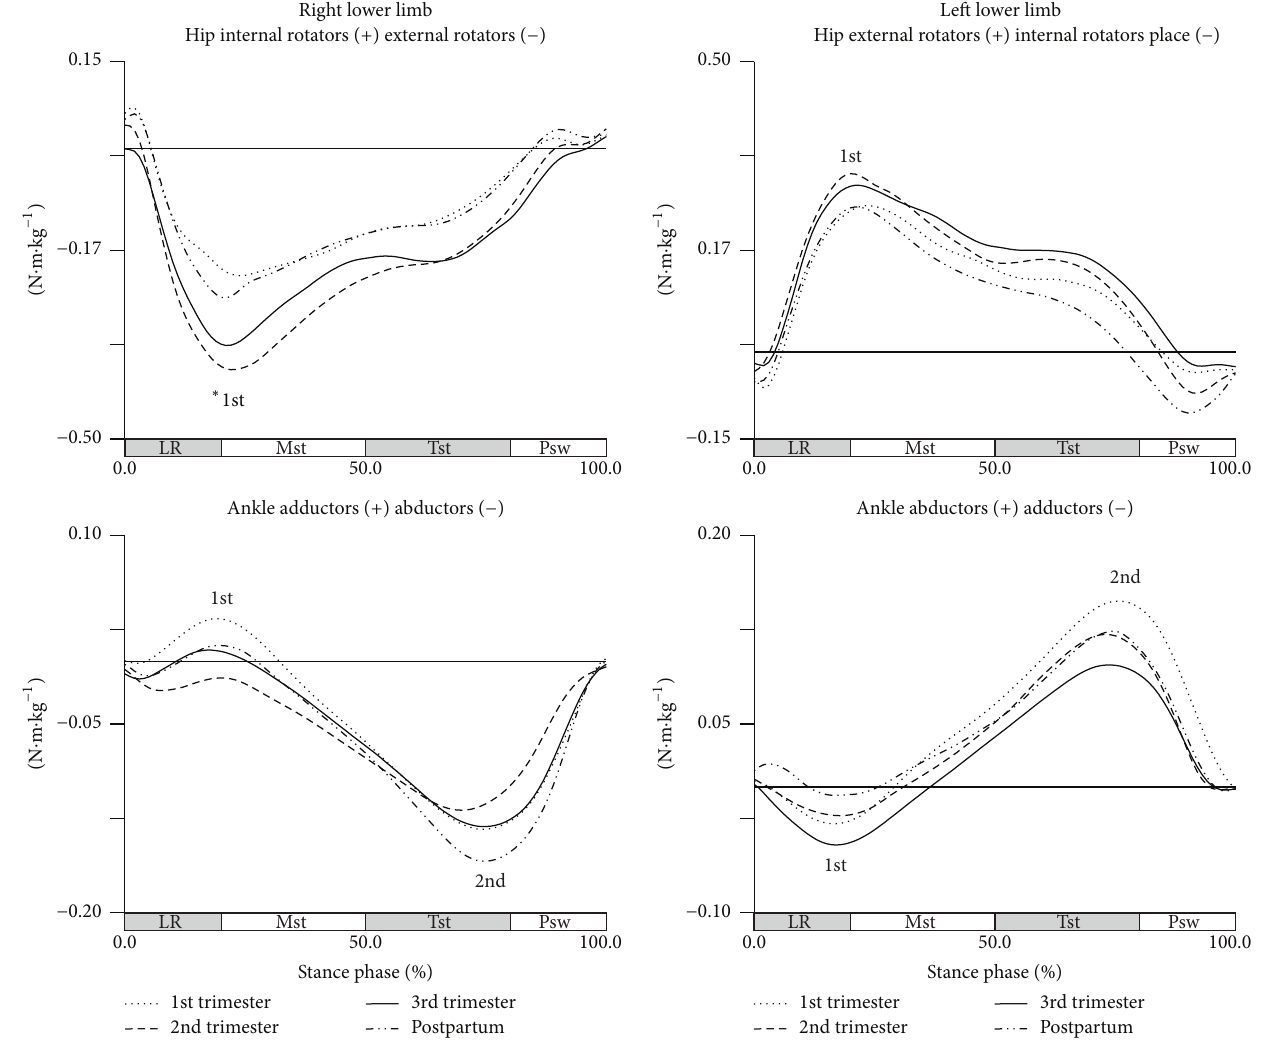
Figure 4: Joints moments in the transverse plane during gait (in N ⋅ m ⋅ kg −1 ). Each line represents the later stages of first (dotted line), second (dashed line), and third trimesters (solid line) and of postpartum period (dash-dot-dot line). Mean joint moments of the hip and ankle, for right and left lower limbs. The curve peaks are indicated by numbers: 1st and 2nd, and ( ∗ ) points the significant